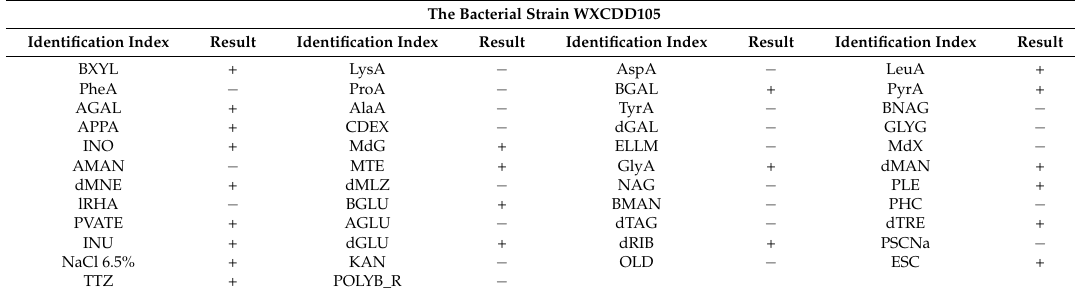
Table 2. The results of the bacterial automatic identification system of the strain